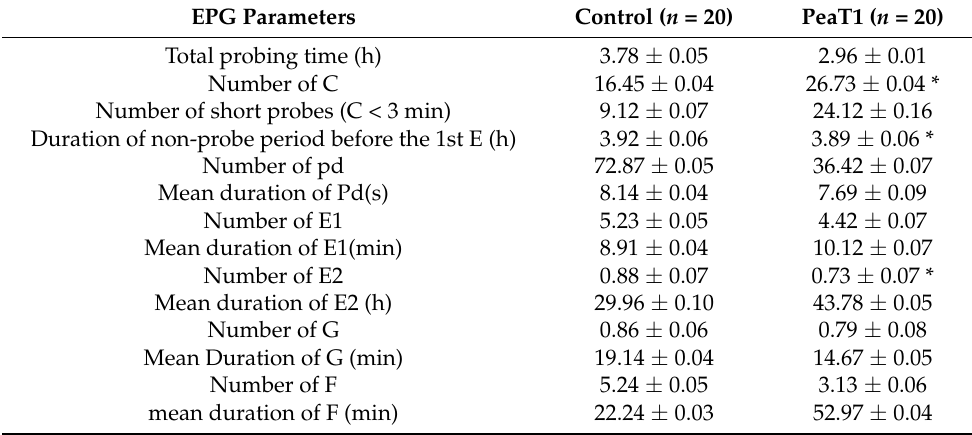
Table 3. M. persicae electrical penetration graph (EPG) data on PeaT1-treated and untreated chilli plants. Mean ± SD. Pathway activities are represented by C, potential drop is represented by Pd, phloem-feeding E represents activities, F represents penetration difficulty, G represents xylem-feeding activities, saliva injection is represented by E1, and sap sucking is represented by E2. Data were compared statistically using an independent t -test with two tails in SPSS 18.0. The difference between PeaT1 and control treatment with the same parameters of * ( p = 0.05) is shown by